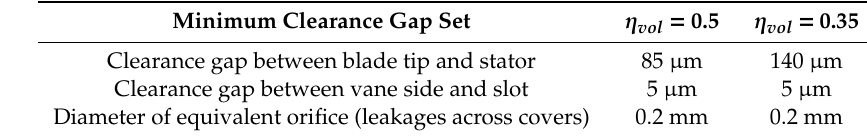
Table 3. Minimum clearance gaps set.